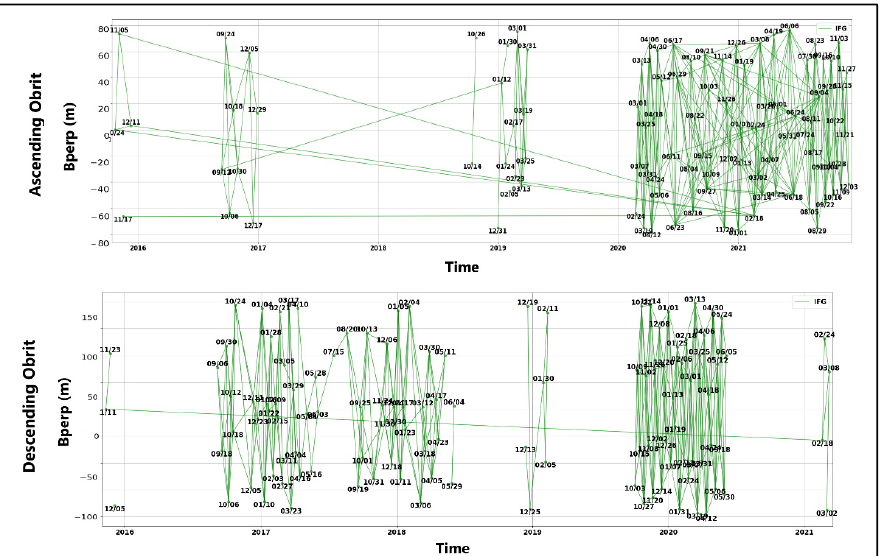
Figure 4. Perpendicular baseline configuration and network of the 346 small baseline interferograms formed from 99 Sentinel-1A images (ascending track, top panel) and network of the 317 SB interfer- ograms formed from 120 Sentinel-1A images used in this study (descending track, bottom panel). Vertical lines indicate the network gaps.